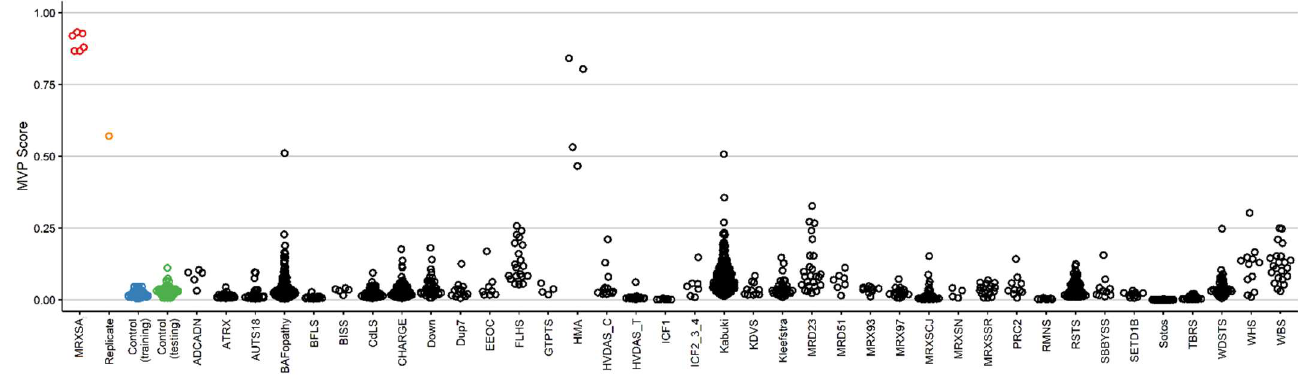
Figure 4. The methylation variant probability (MVP) scores created by the support vector machine (SVM) trained by comparing the 6 cases of MRXSA against healthy control subjects. The red circles represent the case samples, the orange circle represents sample B from Patient 4, the black circles represent cases from the other 36 neurodevelopmental disorders and congenital anomalies (ND/CAs), the blue circles represent training control samples, and the green circles represent testing control samples.